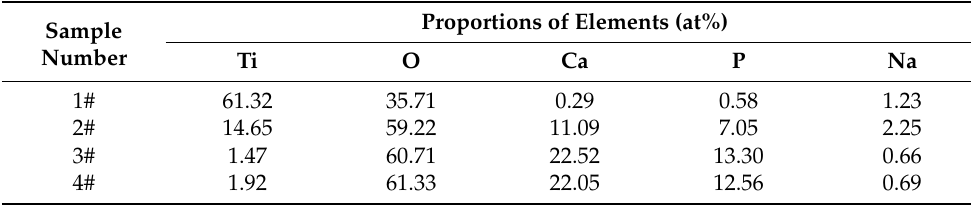
Table 2. The proportions of elements present on the Ti surfaces of test samples after 14 days of